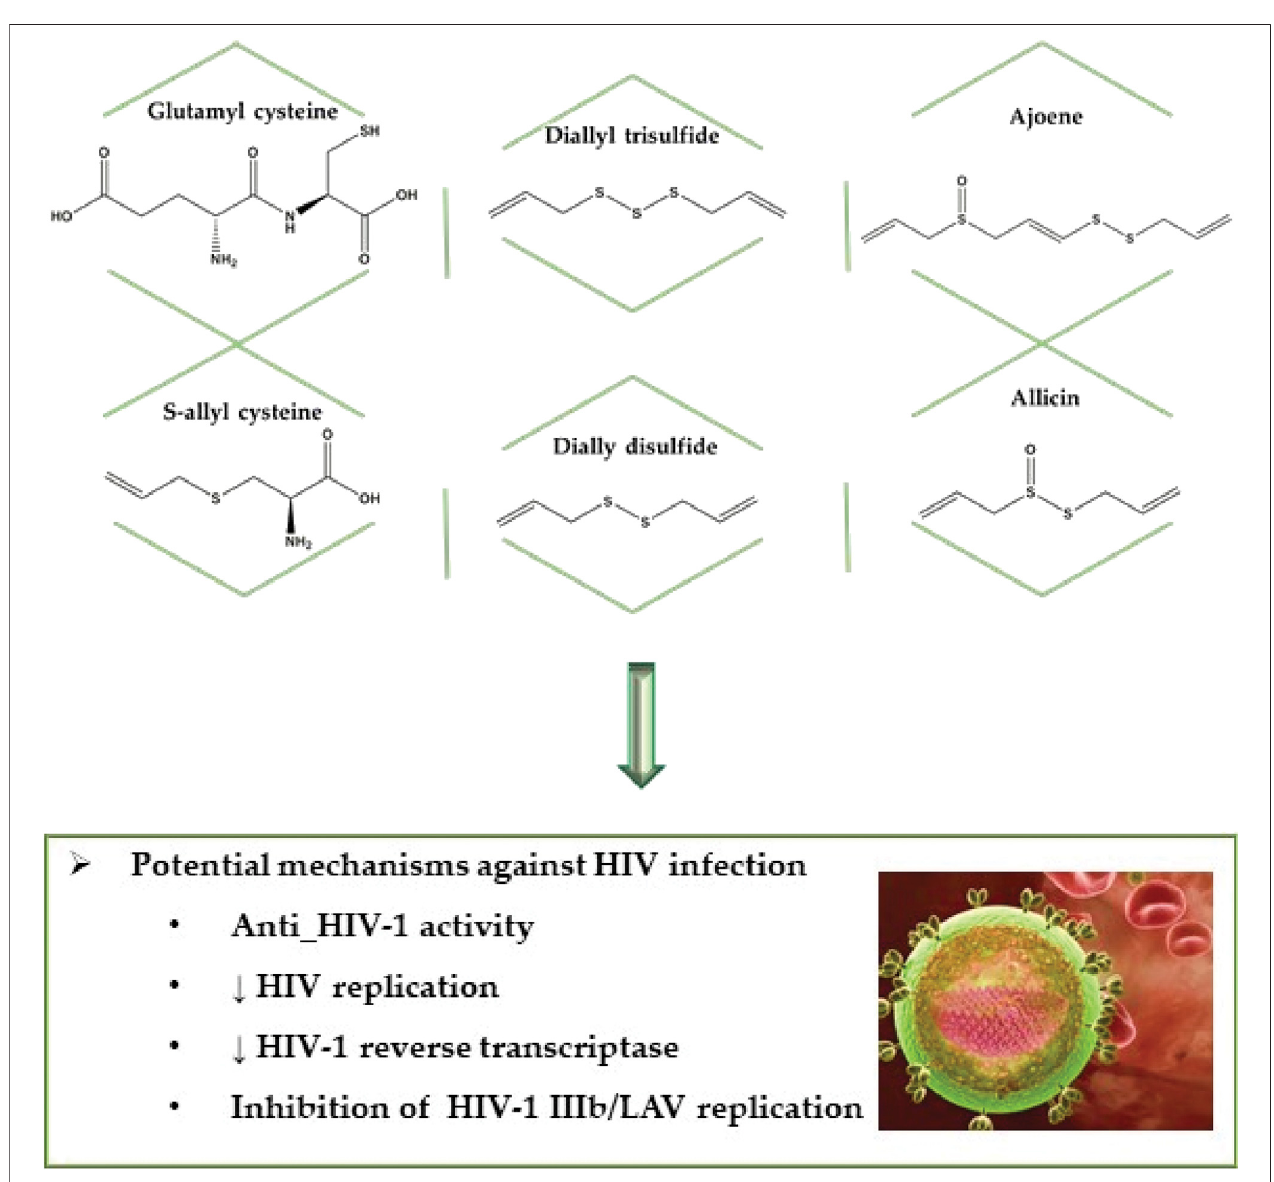
FIGURE 6 | Bioactive compounds against human immunode fi ciency virus type 1 (HIV-1) virus.